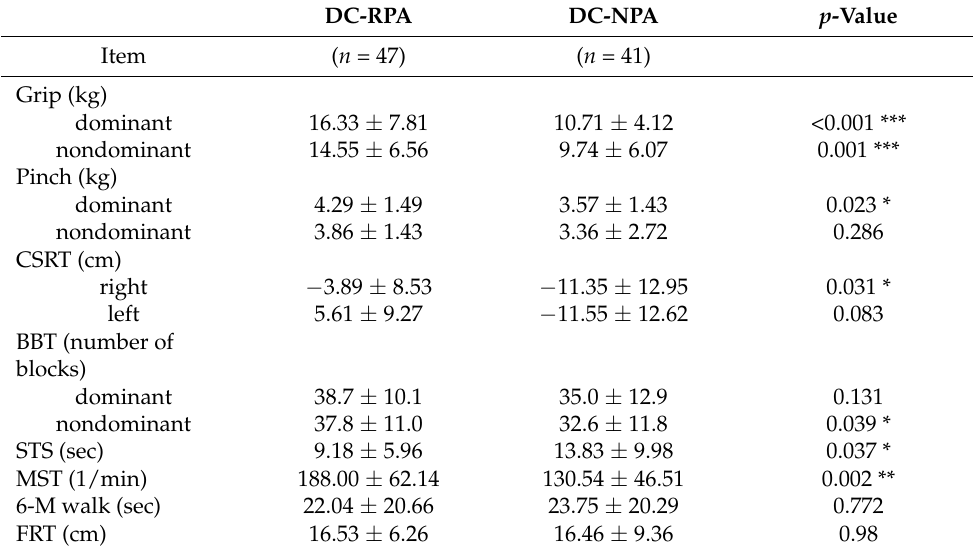
Table 4. The comparison of physical performance between the RPA and the NPA subgroups in DC group.